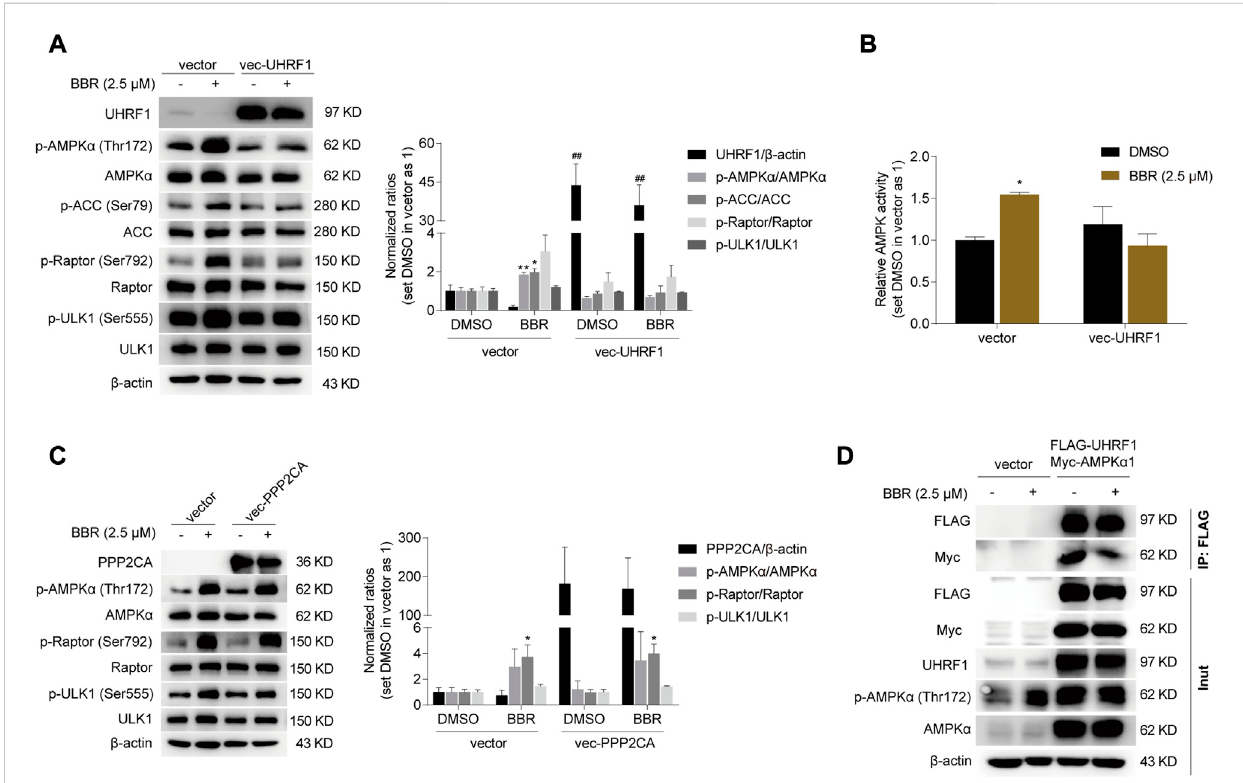
FIGURE 5 UHRF1 overexpression abolished the effect of BBR on AMPK activation. Overexpression of UHRF1 abolished BBR ’ s effect on stimulating phosphorylation of AMPK α and AMPK activity (A, B) . PPP2CA overexpression did not in fl uence BBR ’ s effect on phosphorylation of AMPK α , Raptor and ULK1 (C) . 24 h after transfection, cells were treated with DMSO and BBR (2.5 μ M) for 20 h, respectively. The ratio was set as 1 in the empty vector transfected cells treated with DMSO. * p < 0.05, ** p < 0.01 versus that of the DMSO treated group in the corresponding transfected cells; ## p < 0.01 versus that of the corresponding treated group in the empty vector transfected cells. BBR reduced the interaction between UHRF1 and AMPK α 1 (D) . 24 h after transfection, the cells were starved overnight and treated with DMSO and BBR (2.5 μ M) for 1 h, respectively. IP was performed as described in